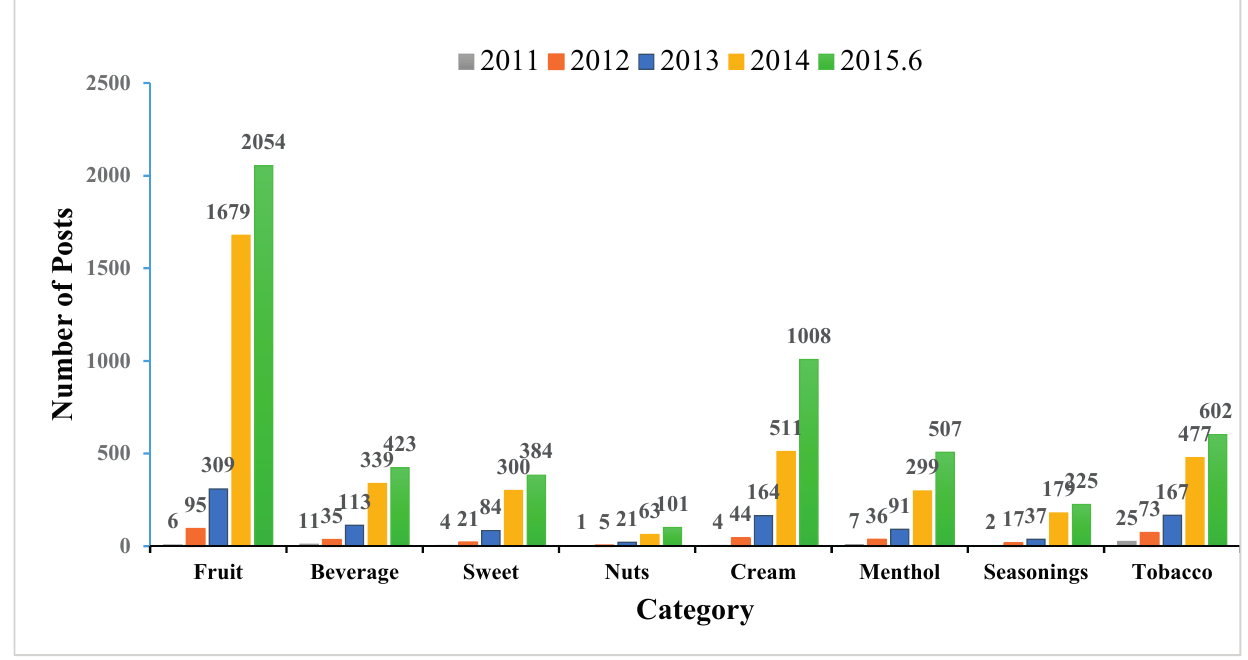
Figure 3. Temporal trends for flavor categories.